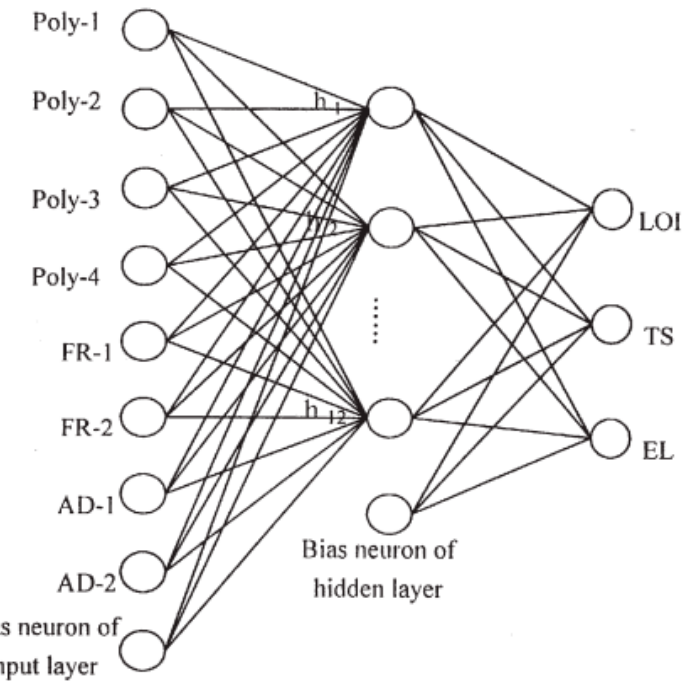
Figure 11. The schematic of the ANN to predict the LOI, tensile strength (TS), and elongation (EL) values of flame-retardant composites. Adapted with permission from ref. [102]. Copyright 2001 Journal of Fire Sciences.